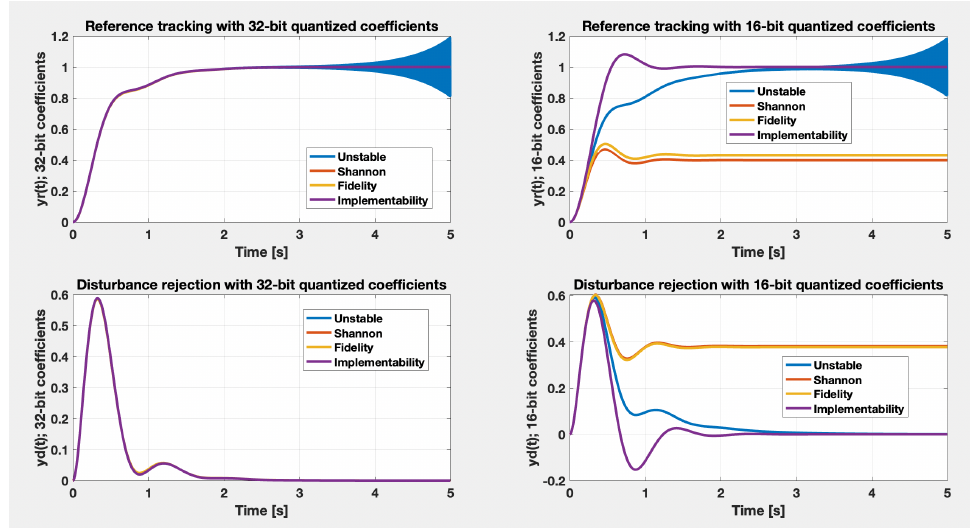
Figure 9. DC motor example closed-loop step responses using the proposed 2DOF control structure; the first line gathers the reference tracking behavior with 32-bit and 16-bit quantized regulator coefficients, respectively, while the second line gathers the disturbance rejection behavior in the same 32-bit and 16-bit